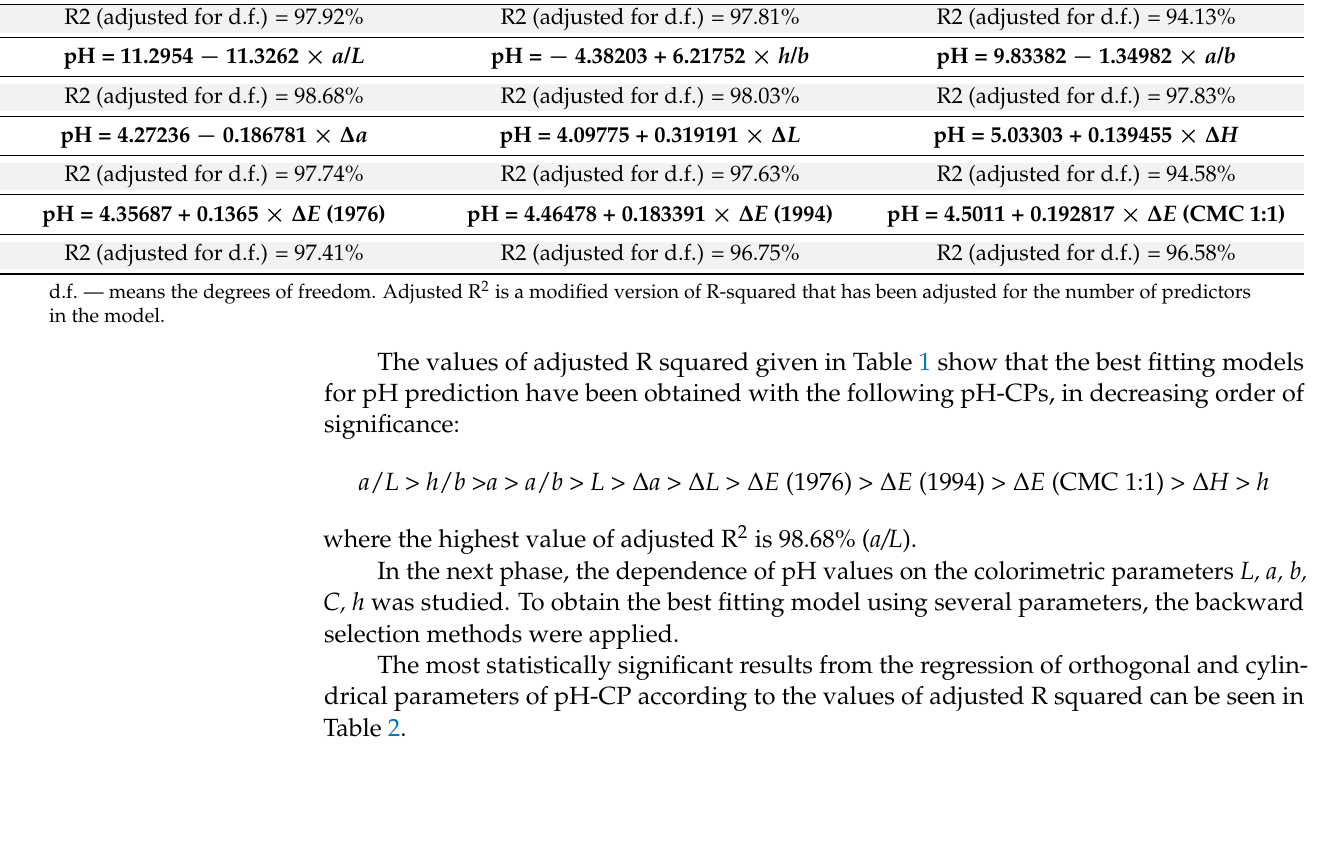
Table 1. The best results for the simple linear regression between pH-CPs and pH. pH = 12.0005 − 0.187229 × a pH = − 16.3868 + 0.318285 × L pH = 3.66558 + 0.0896278 × h R2 (adjusted for d.f.) = 97.92% R2 (adjusted for d.f.) = 97.81% R2 (adjusted for d.f.) =